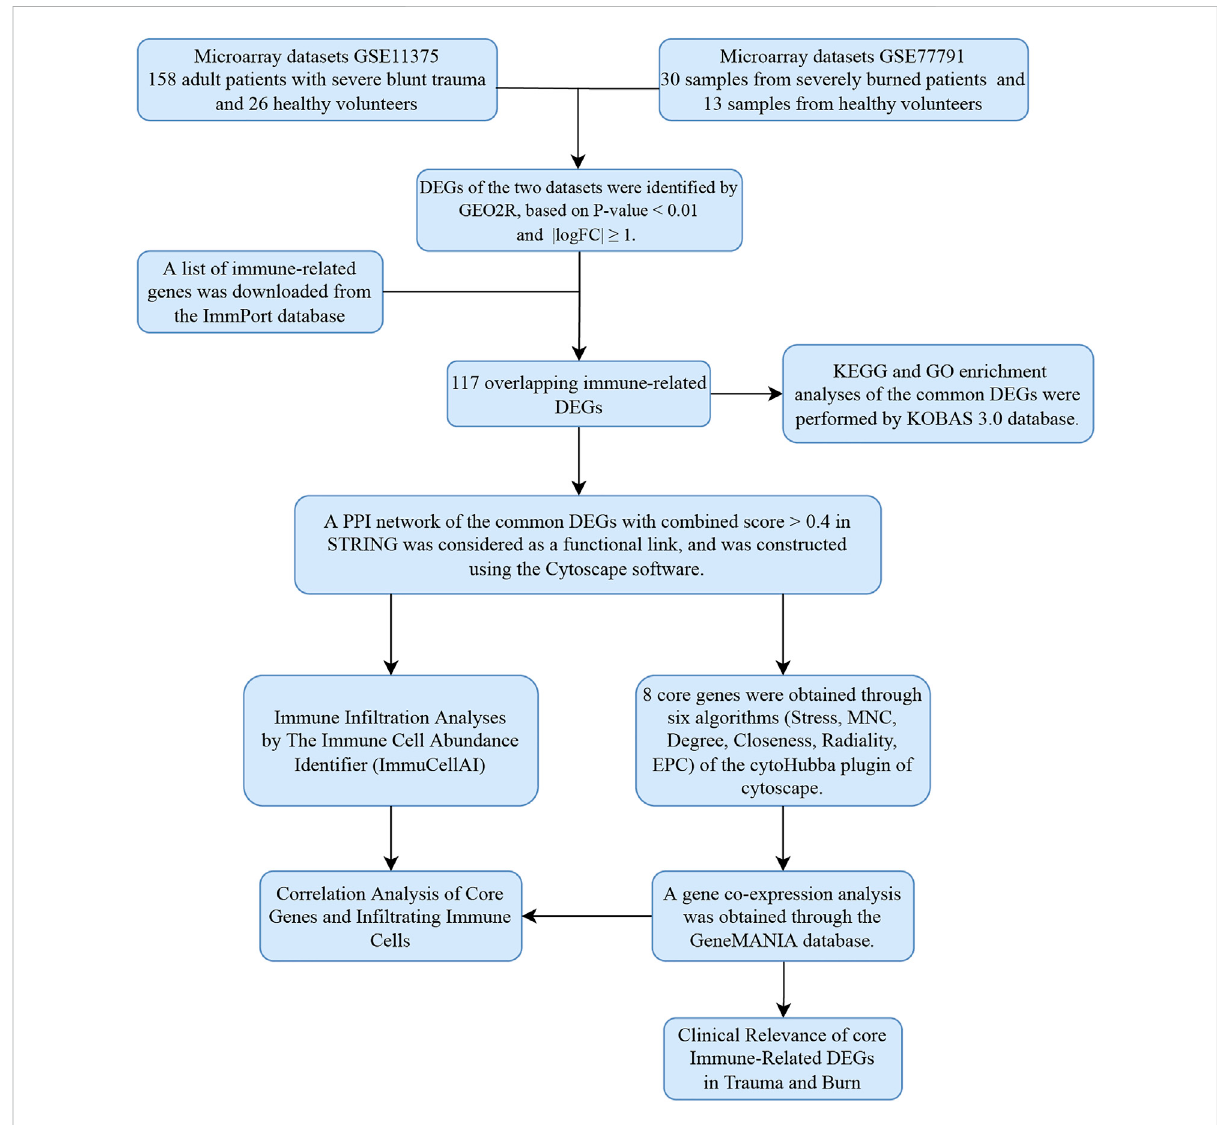
FIGURE 1 Research design fl ow